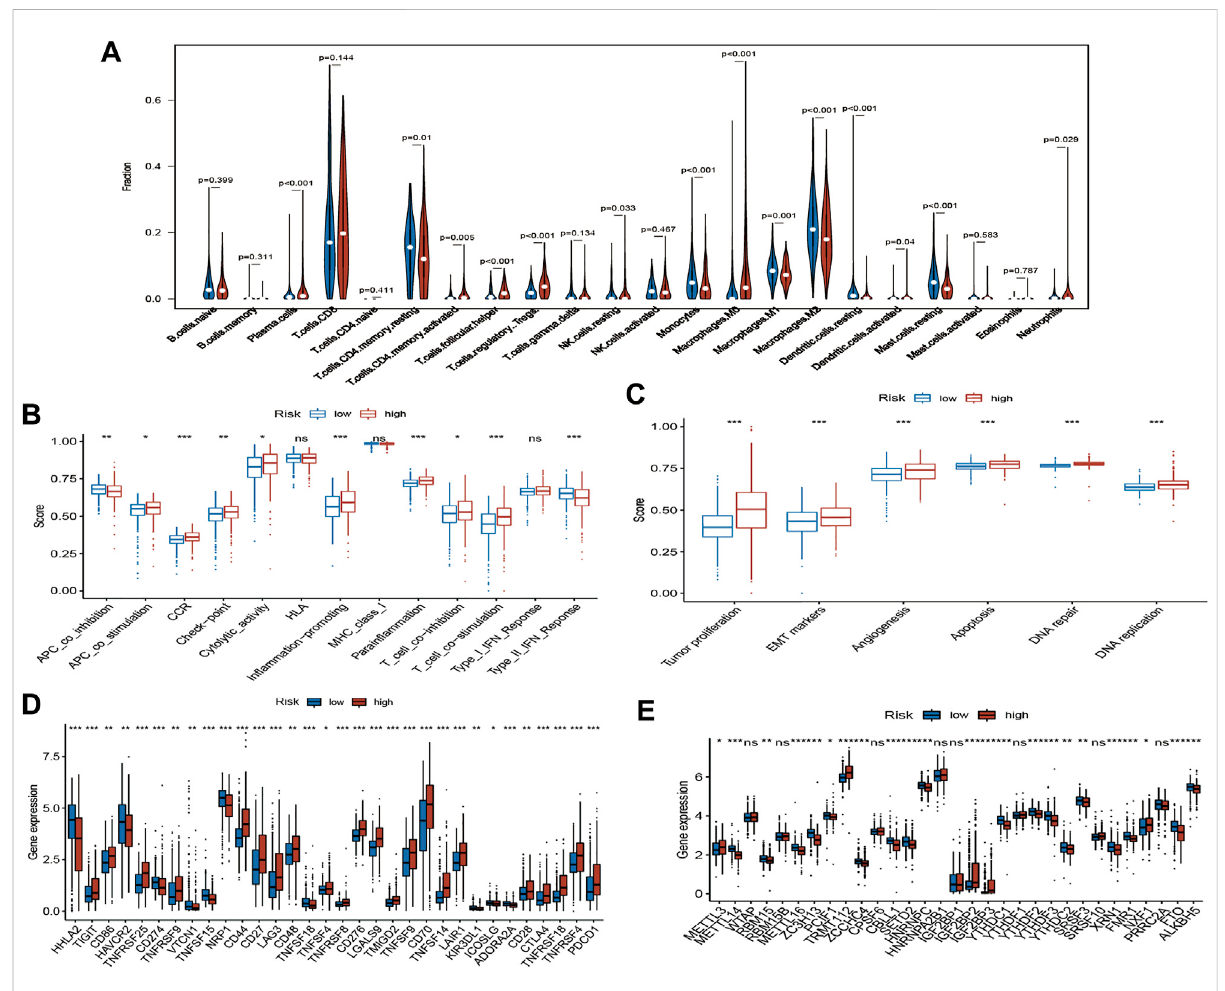
FIGURE 9 Immunein fi ltration,immunestatusandcellpathwayevaluation,andimmunecheckpointsandm 6 A-relatedgenesanalysis. (A) Theviolinplotof immunecellsproportionofthehigh-riskandlow-riskgroupviaCIBERSORT;Thedifferentimmunestatus (B) andcellpathway (C) betweenthehigh- risk and low-risk group via ssGSEA; (D) Gene expression analysis of immune checkpoints between the high-risk and low-risk group; (E) Gene expression analysis of m 6 A-related genes between the high-risk and low-risk group; ns: p ≥ 0.05; *: p < 0.05; **: p < 0.01; ***: p <